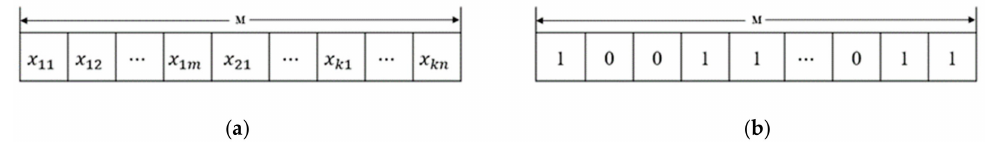
Figure 4. Gene coding of decision variables. ( a ) Real swing angle coding; ( b ) Binary-selected stripe coding.